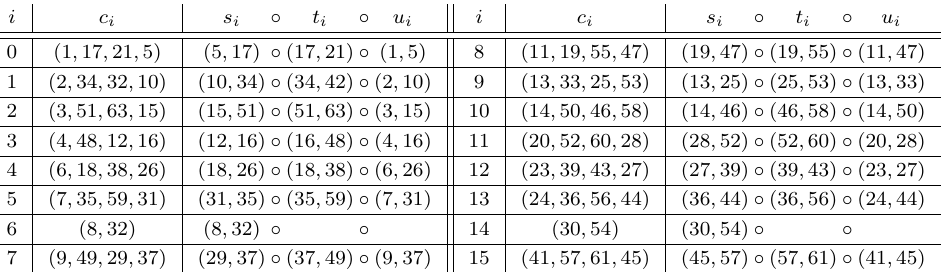
Table 5: Decomposition of the c i ’s in the GIFT